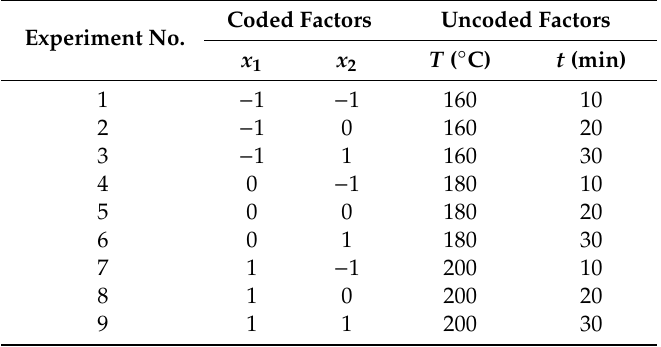
Table 1. Full factorial design used for the roasting process of the date seeds. Coded Experiment No.